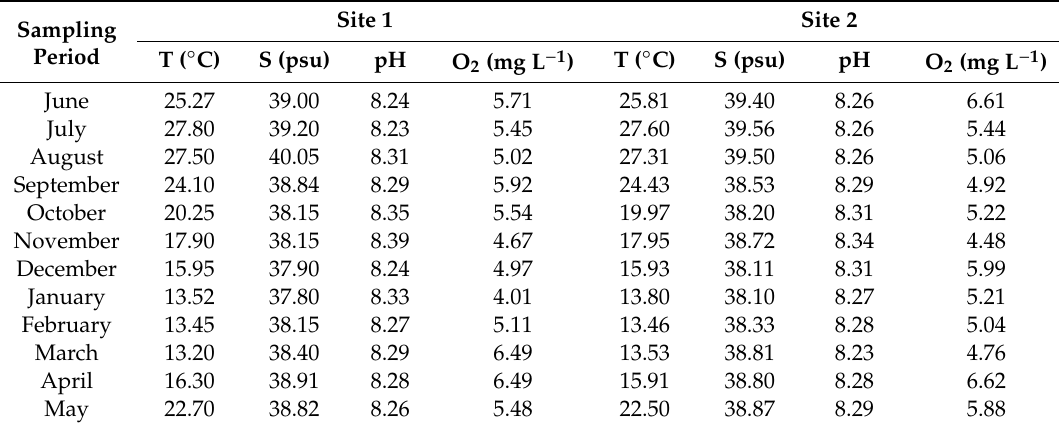
Table 1. Spatial variation of the physical (T, temperature; S, salinity) and chemical (pH; O 2 , dissolved oxygen) parameters recorded in the Pagasitikos Gulf surface